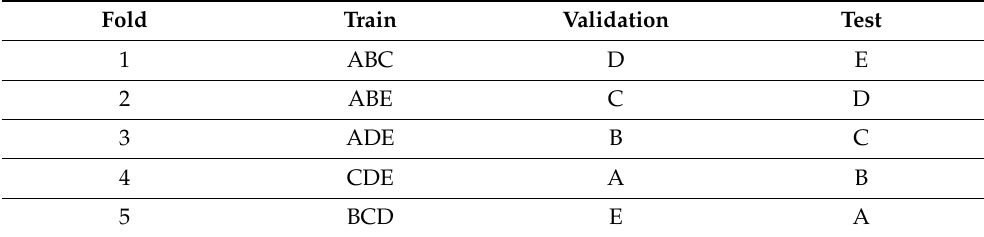
Table 2. Cross Fold